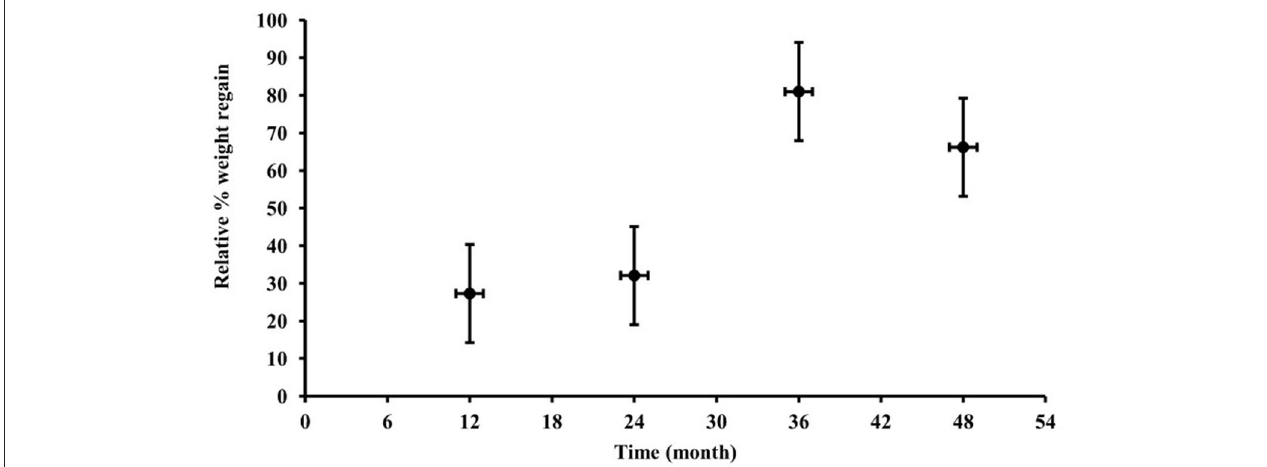
FIGURE 1 | Relative percentage weight regain in milk diet completers (from completion of the intervention at 6 months) in participants followed in the 1st, 2nd, 3rd, or 4th year. Percentages of weight regain are presented as medians and interquartile ranges (vertical error bars) while horizontal error bars depict the standard deviations of time to follow-up (in